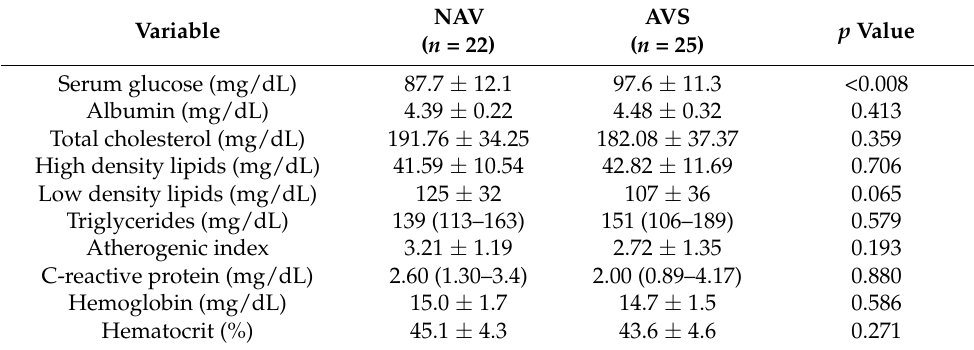
Table 3. Biochemical parameters of the study participants. Data are shown as mean ± standard deviation or median (percentile 25–percentile 75).